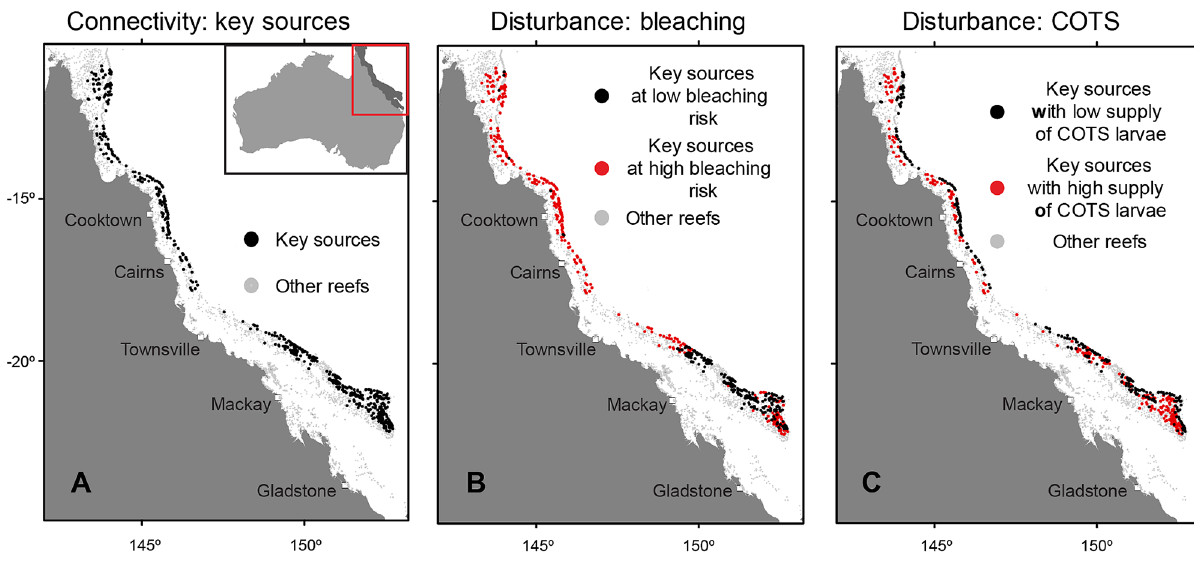
Fig 2. Identifying reefs that exhibit high connectivity and low disturbance exposure. (A) Locationsof key source reefs on the GBR with high replenishment potential. (B) Classification of key source reefs accordingto bleachingrisk ( > 6 DHW) duringmajor bleachingevents between1982 and 2017. (C) Classification of key sources accordingto their predictedsupply of COTS larvae. Data providedin S1 Data. COTS, crown-of-thorns starfish; DHW, degreeheatingweeks; GBR, Great Barrier